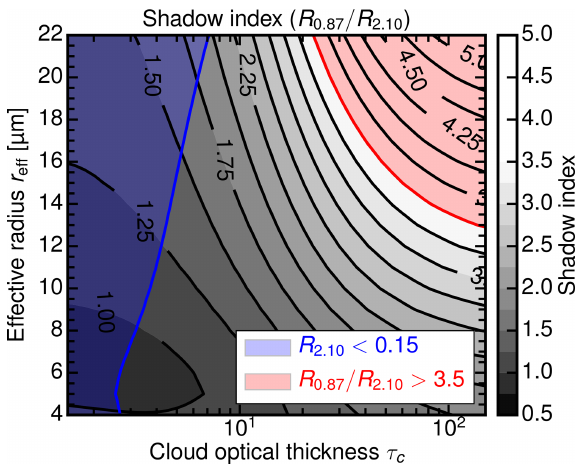
Figure 17. Shadow index R 0 . 87 /R 2 . 10 for water clouds as a func- tion of effective radius r eff and cloud optical thickness τ c for the ge- = 30 ◦ ), with high absorption at 2 . 1µm. Like ometry ( ϑ ∗ = 0 ◦ , ϑ ∗ 0 in Fig. 16, the blue area indicates the simple reflectivity threshold R 2 . 10 < 0 . 15 while the red area indicates the shadow index thresh- old R 0 . 87 /R 2 . 10 > 3 .